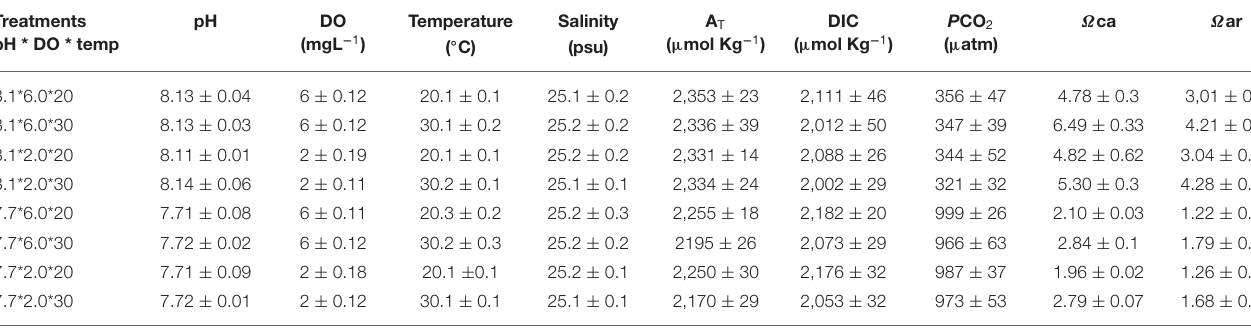
TABLE 1 | Seawater carbonate chemistry variables (mean ± SD, n = 4) during the whole experimental period. Treatments pH * DO * temp